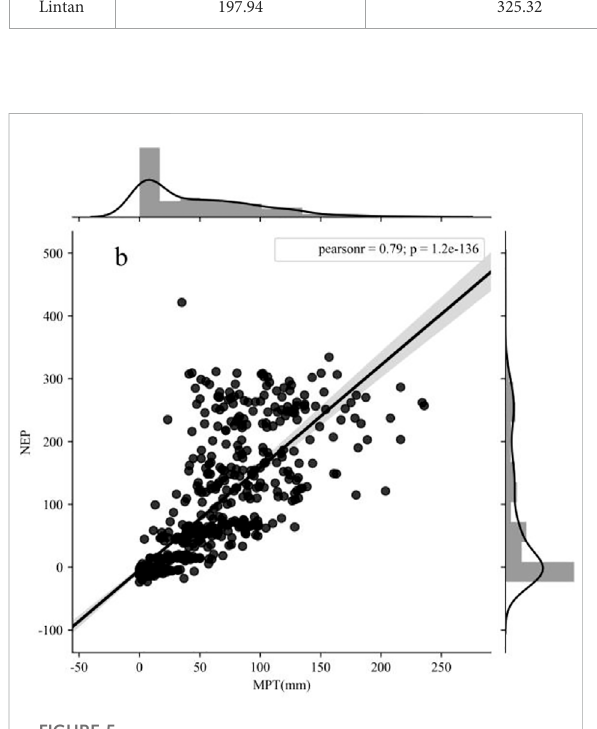
FIGURE 5 ScatterplotbetweenthetemperatureandNEP.Note:Figures 5, 6 are both drawn using Python, which is relatively easy to use software.